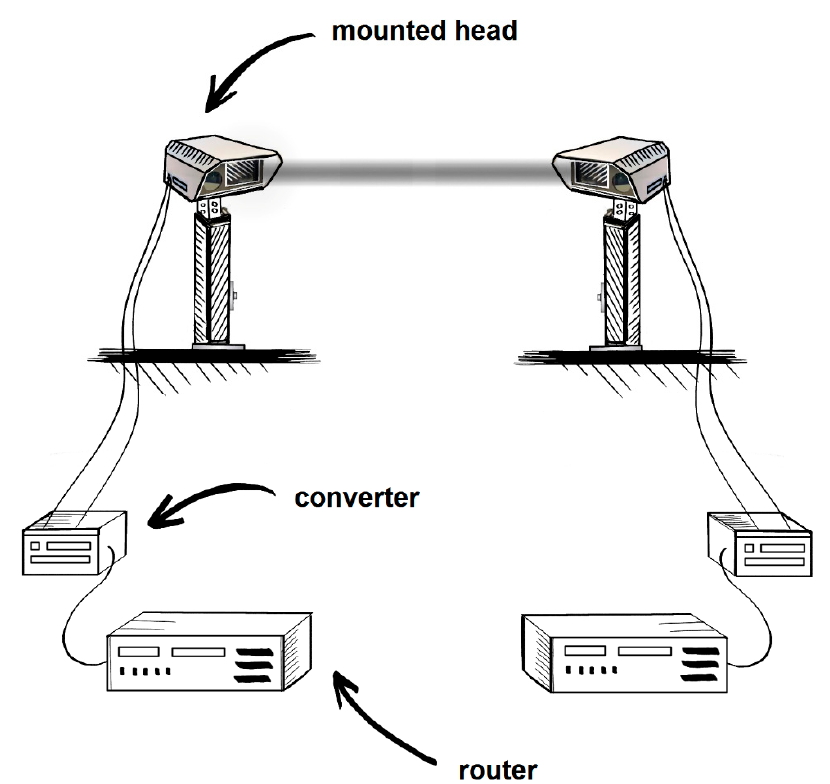
Figure 4. The scheme of the data transmission via Free Space Optics (FSO) technology between two heads.